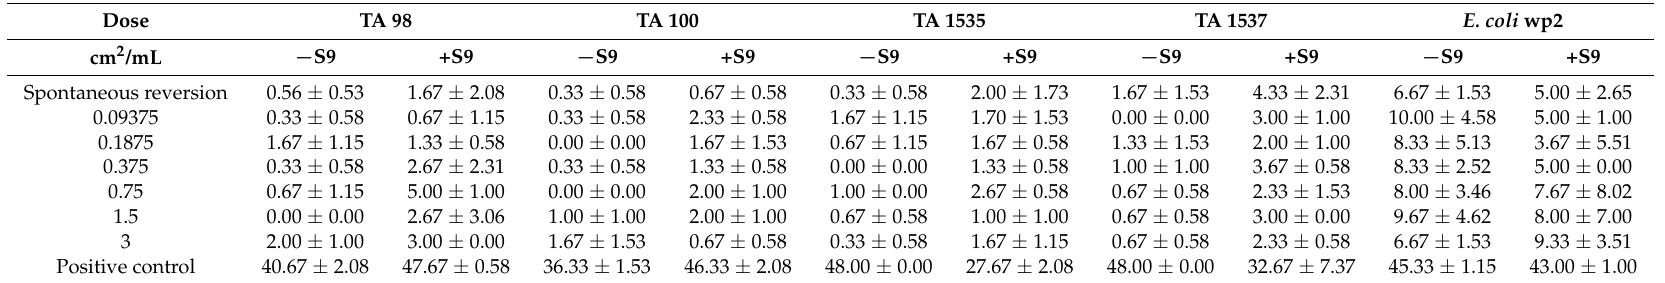
Table 9. Number of positive cells in Ames test of PLGA + IGF1.